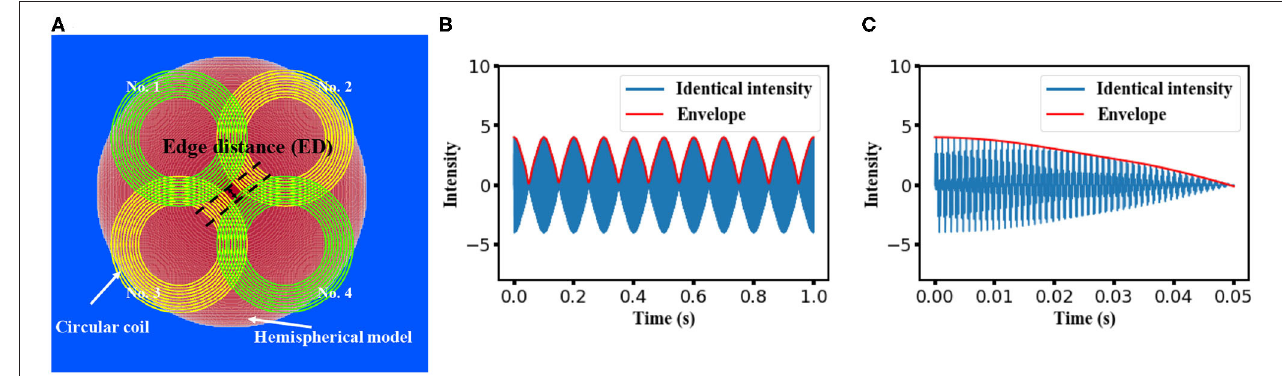
FIGURE 1 | Proposed design for temporal interference magnetic stimulation on a hemispherical model. (A) The construction of the stimulation coils and the isotropic head model. A clover-shaped coil array constructed with an inner diameter of 60 mm and an outer diameter of 100 mm. Coils with identical color comprise a “temporal interference set” and are aligned on the same planes at vertical distances of 5 mm and 10 mm above the hemispherical model. (B) Feasibility of generating a low-frequency modulation from the four individual waves with a normalized intensity of 1(frequency of 1, 1.01 kHz, 5, and 5.01 kHz, respectively). A time length of 1 s was displayed, and a 10 Hz envelope was observed. (C) Same modulation wave with (B) but with a time length of 50